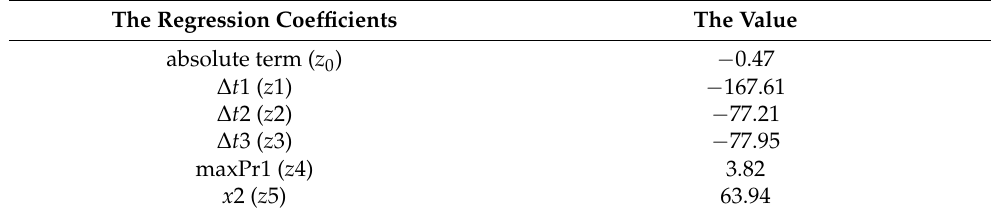
Table 4. The calculated regression coefficients.